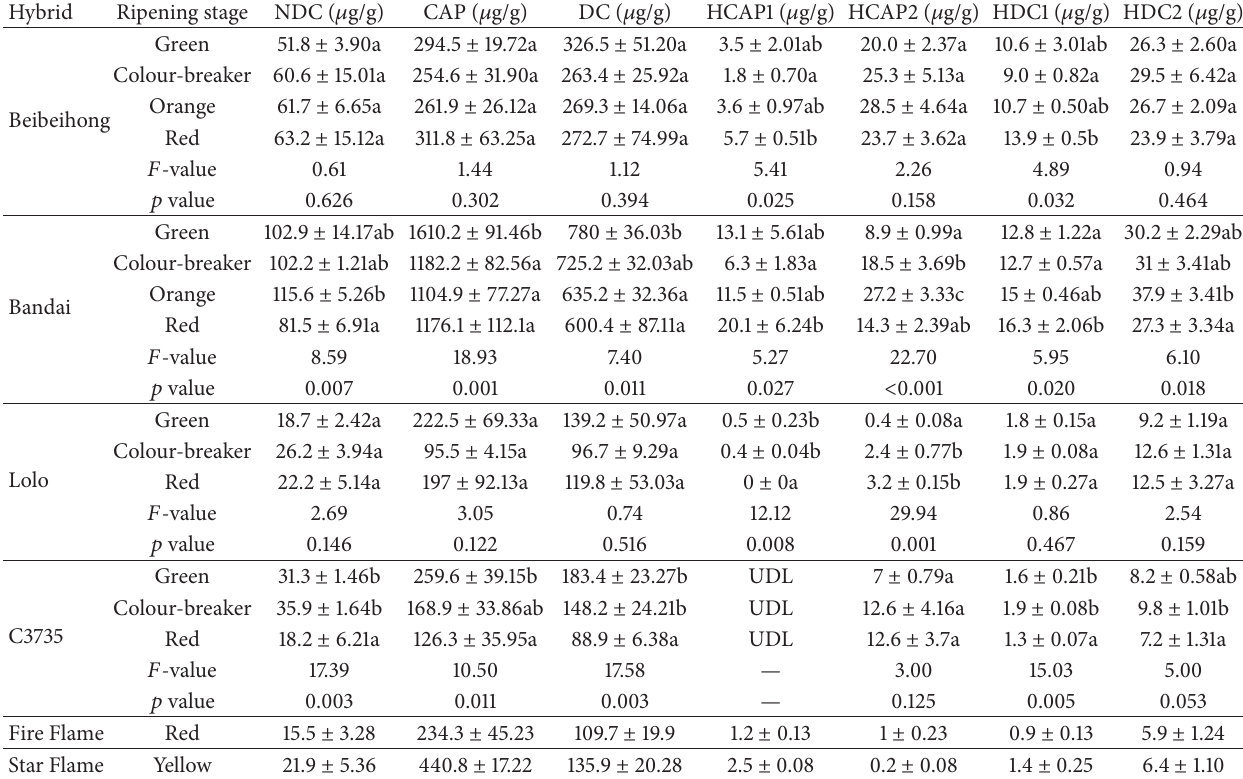
Table 2: Change in content of capsaicinoid compounds in chili hybrids as a function of ripening. The values represent means in 𝜇 g/g fresh base weight ± standard deviation ( 𝑛 = 3